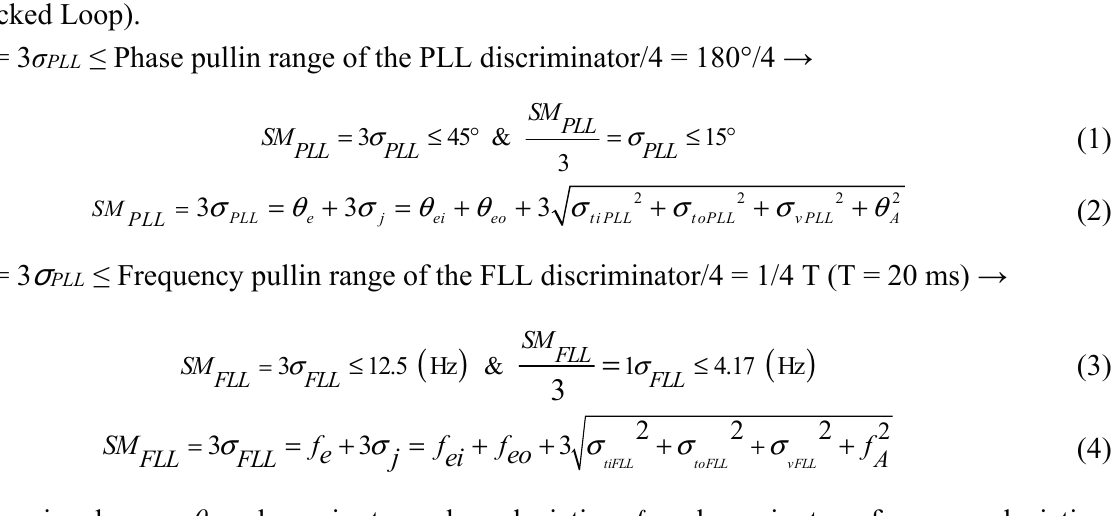
Figure 3. The usual expressions for these disturbances are: Frequency error: